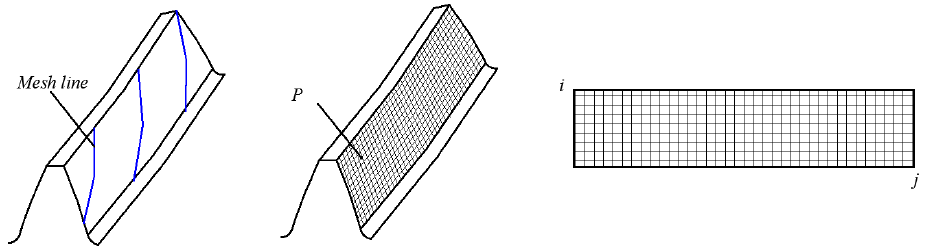
Figure 3. Mesh grid on the gear tooth flank.